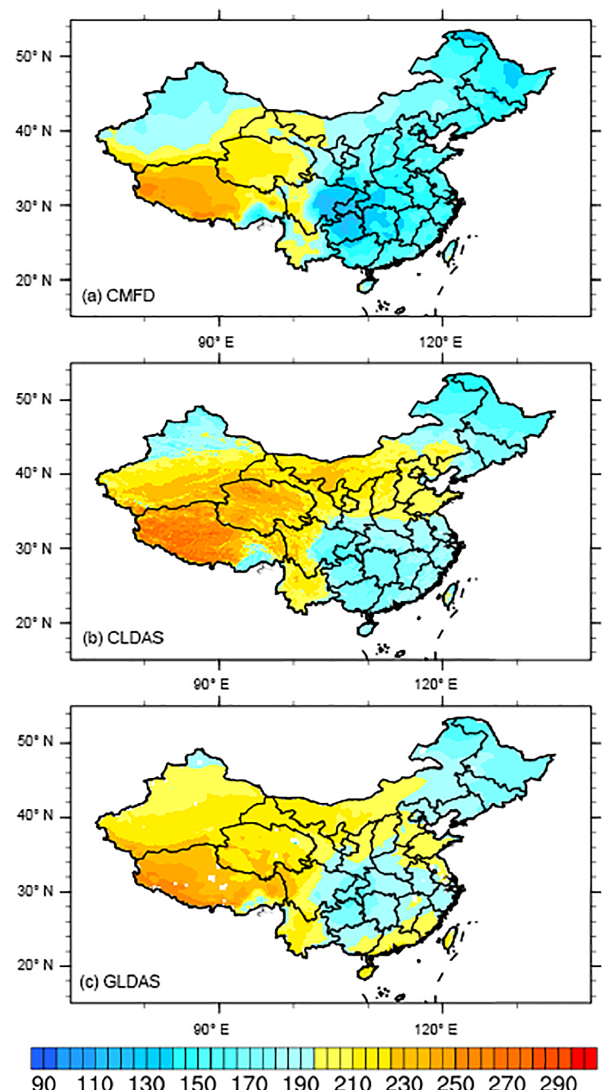
Figure 10. Spatial distributions of annual-mean shortwave radiation based on the three forcing data sets over 2008–2014 (unit: Wm − 2 )